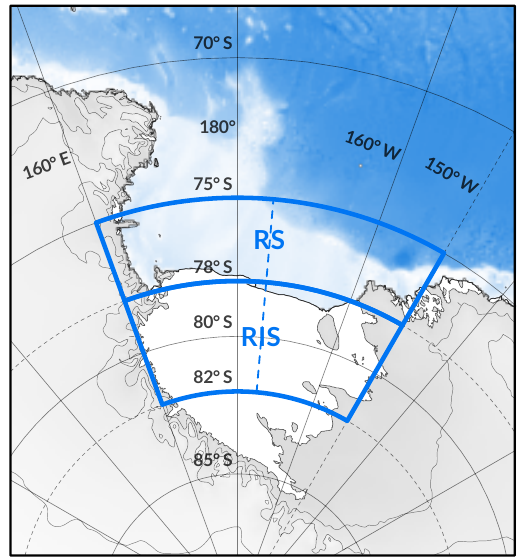
Figure 1. Topographic map of the RIS and Ross Sea including the boundaries of the study area (thick blue line) and border between the RIS and Ross Sea sectors. (Map derived from the SCAR Antarctic Digital